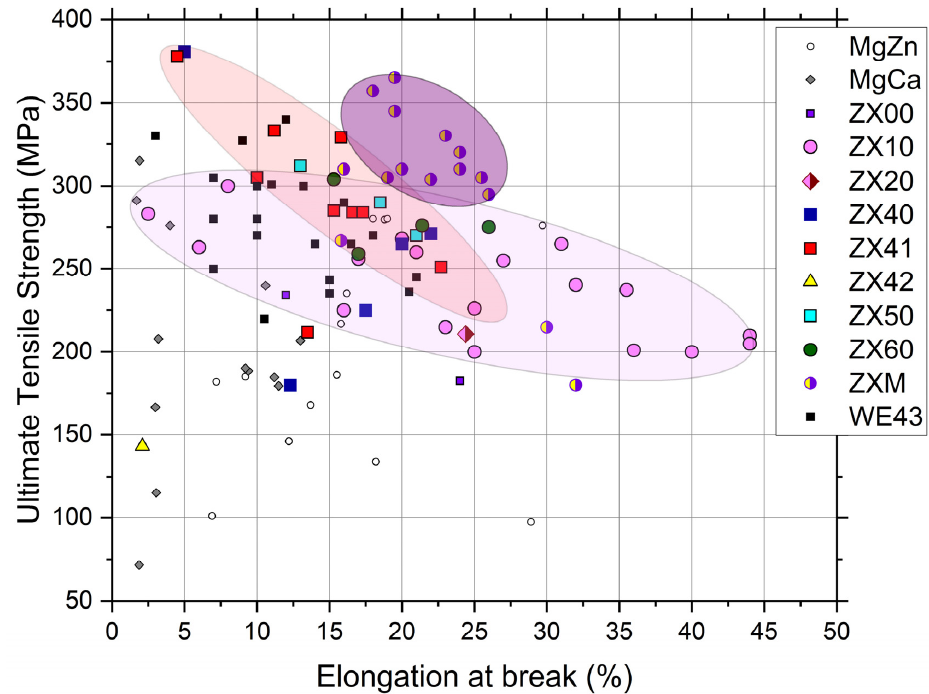
Figure 3. Summary of mechanical properties—strength vs. ductility—of Mg-Zn-Ca alloys with different compositions and microstructures (data are imported from Table 2 and the references therein).